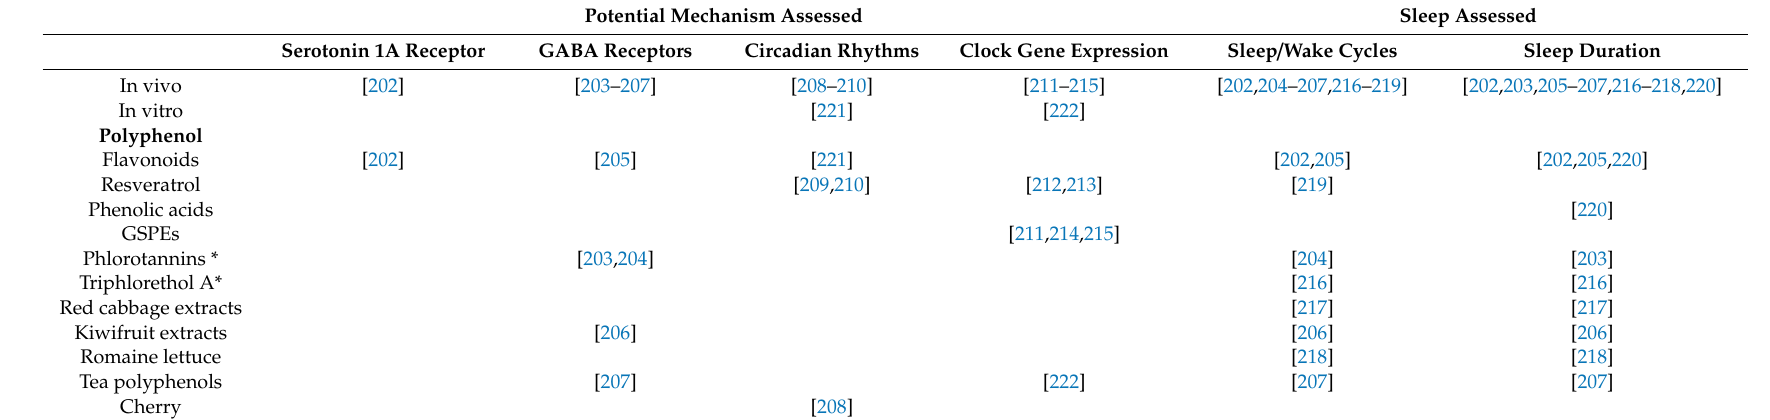
Table 3. Summary of animal and in vitro studies [references] assessing the e ff ects of polyphenols on sleep and their potential